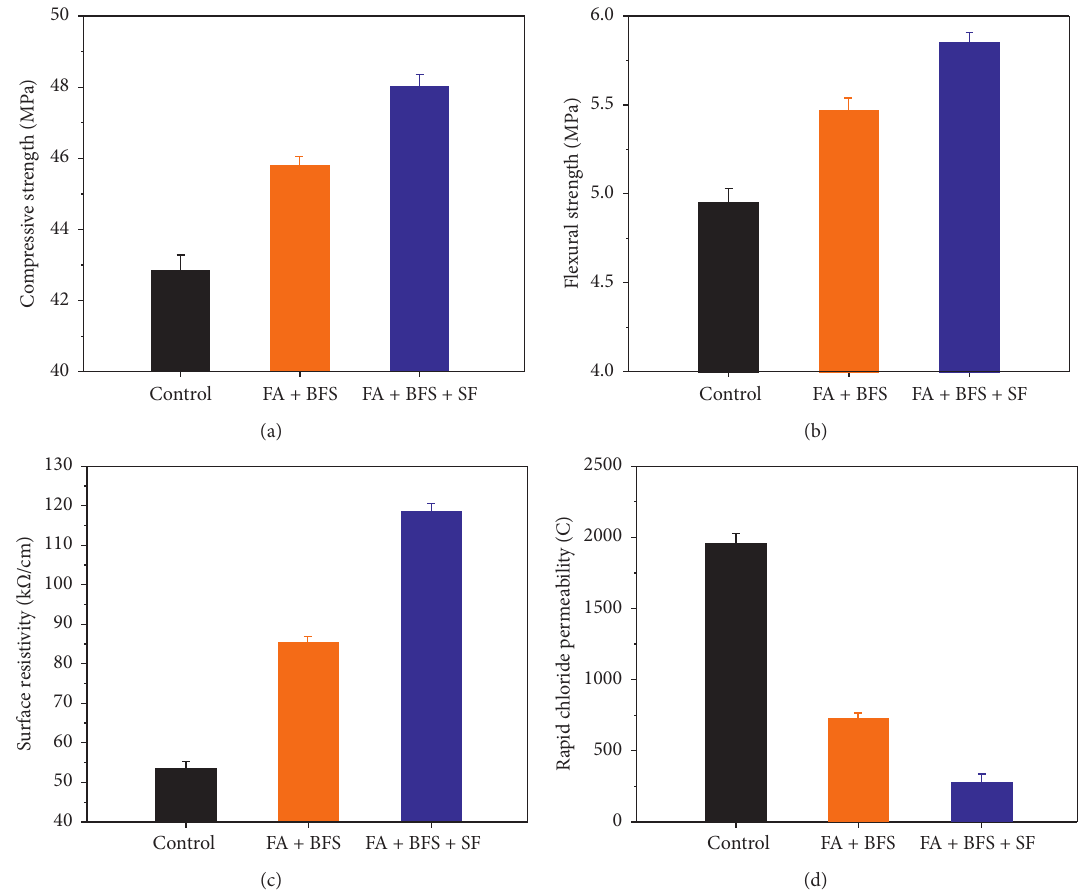
Figure 8: Influence of multimineral admixtures on the performances of concrete. (a) Compressive strength. (b) Flexural strength. (c) Surface resistivity. (d) Rapid chloride